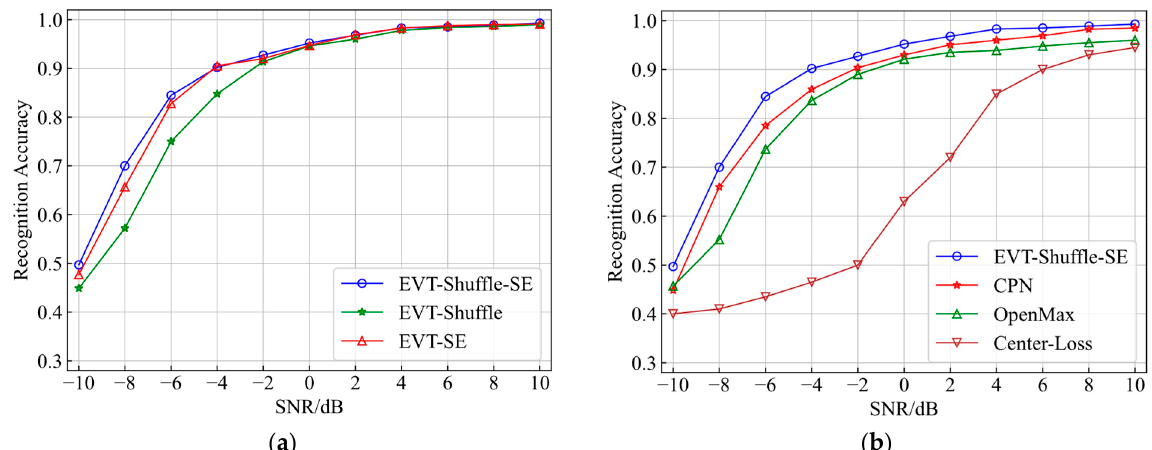
Figure 9. Comparison of recognition accuracy of different models: ( a ) comparison under different modules; ( b ) comparison with other models.